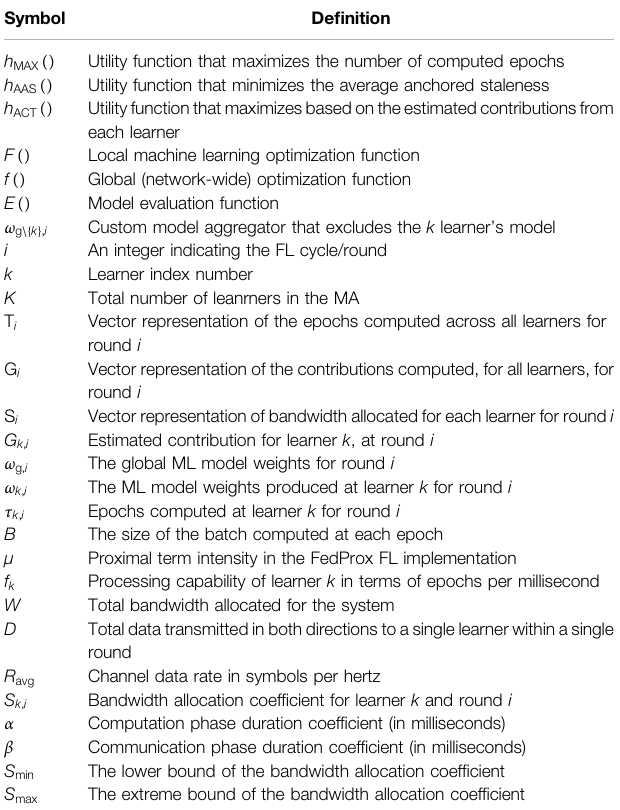
TABLE 1 | Relevant symbols of variables, constants and